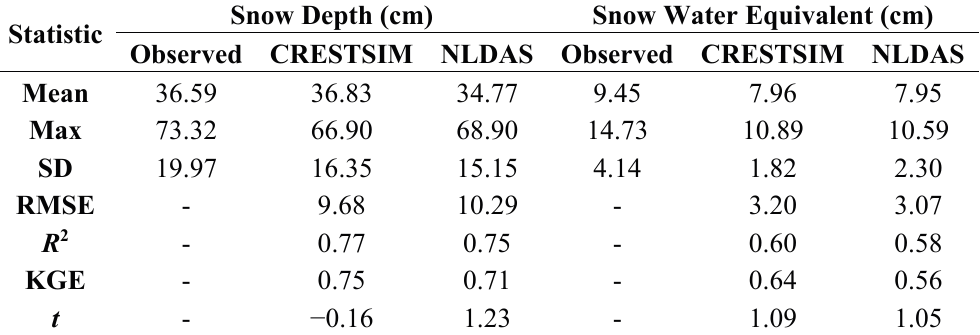
Figure 5. Snow depth Scatter Plot (winter 2011–2012) for both simulated scenarios: ( left ) CRESTSIM; and ( right ) NLDAS. Table 3. Statistics of snow depth and snow water equivalent. Winter 2011–2012. Max is the maximum value for the period. SD is the standard deviation. RMSE is the root mean squared error. The R 2 is the correlational coefficient. The t -test is the t -statistic value for the student’s t -test ( t critical = ±1.66). The number of observations for snow depth was 2030. The number of observations for SWE was